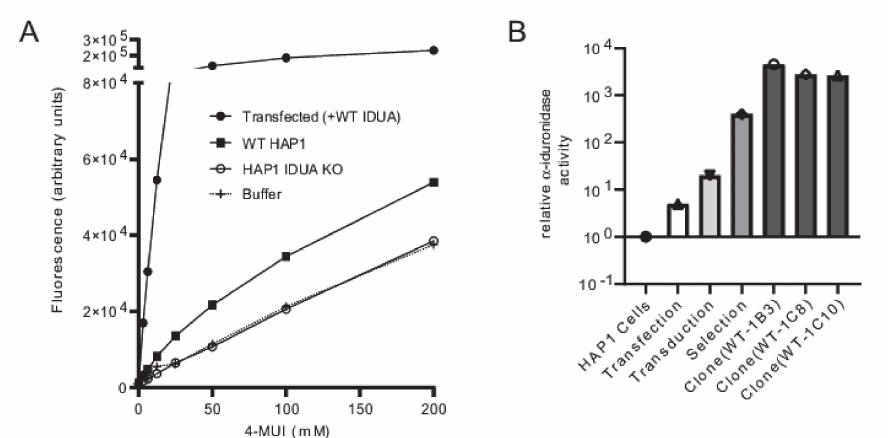
Figure 2. Validation of the IDUA -KO HAP1 cells and α -iduronidase activity enrichment during the selection process. ( A ) Enzyme activity in WT and IDUA -KO HAP1 cells compared α -iduronidase activity in IDUA -KO HAP1 cells transfected with WT IDUA cDNA. ( B ) Enrichment of α -iduronidase activity across di ff erent steps of the selection